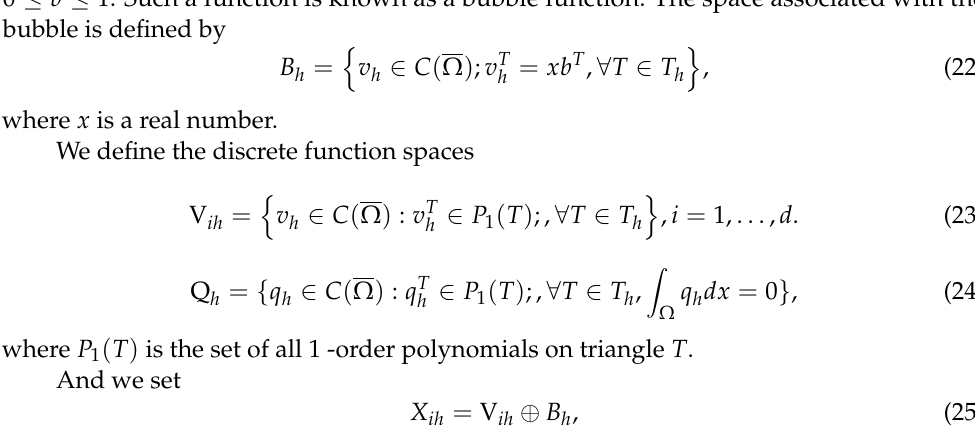
Figure 2. Mini-element P 1 − Bubble / P 1 in 3 D